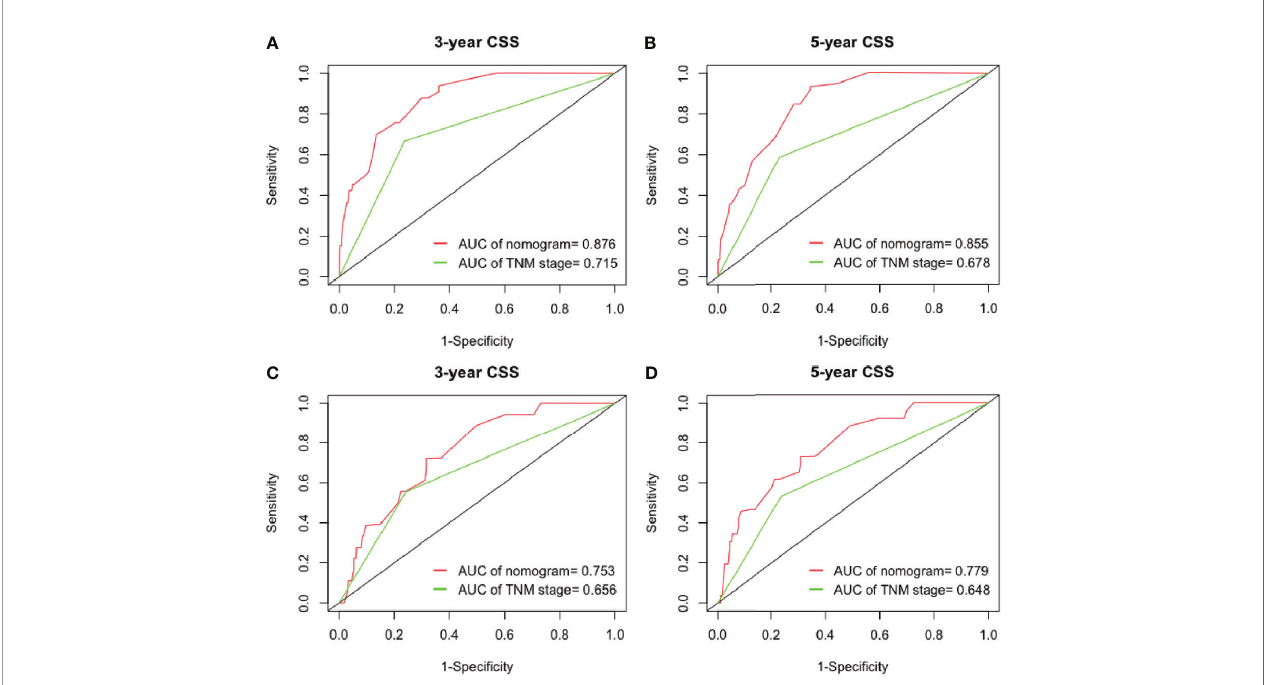
FIGURE 5 | The ability of ROC analysis of nomogram to predict the (A) 3-year and (B) 5-year CSS rate in the training cohort; (C) 3-year and (D) 5-year CSS rate in the validation cohort. ROC, receiver operating characteristic; CSS, cancer-speci fi c survival.